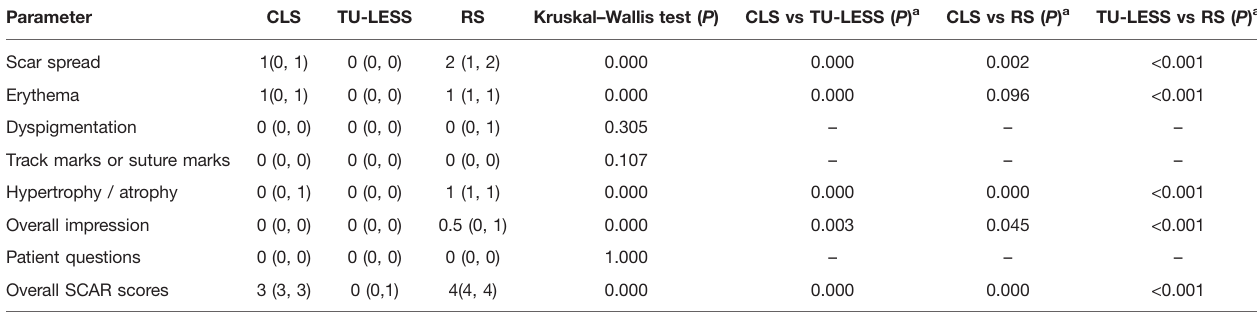
TABLE 4 | Cosmetic effect of surgical scars between three different approaches (median, fi rst and third quartiles).